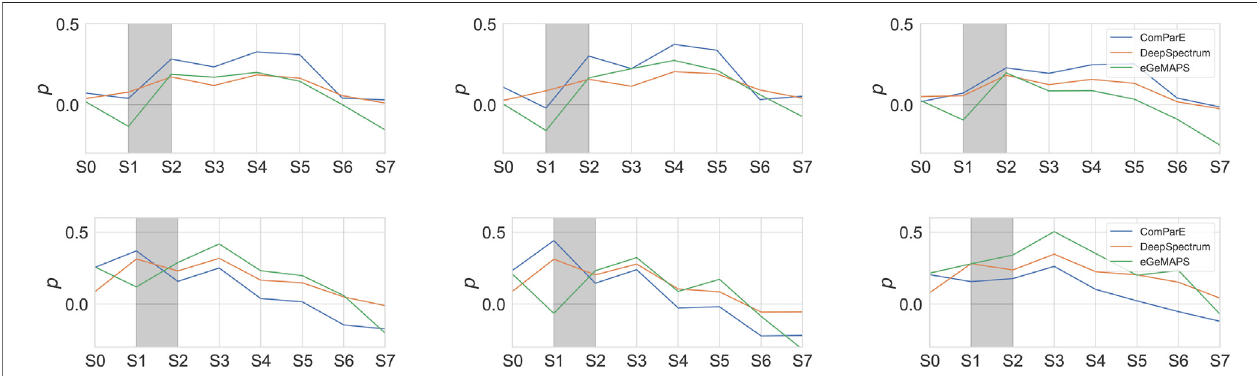
FIGURE 6 | SVR results for the FAU-TSST (above) , and REG-TSST (below) . Reporting Spearman ’ s correlation coef fi cient ( ρ ) for all scenarios (left) , interview task (middle) , and arithmetic task (right) , for each sequential saliva (S) sample. SVR experiments were conducted with three different acoustic feature sets: EGEMAPS , DEEPSPECTRUM , and COMPARE